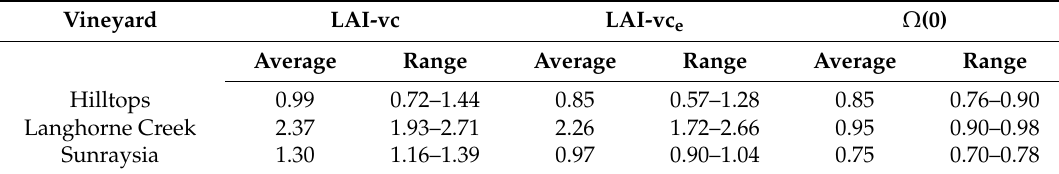
Table 2. Basic statistics (average and range) from results obtained using VitiCanopy to estimate canopy size for three vineyards located in Langhorne Creek (SA), Hilltops (NSW) and Sunraysia (Vic) during the season 2013–14. LAI-vc = plant area index, LAI-vc e = effective plant area index